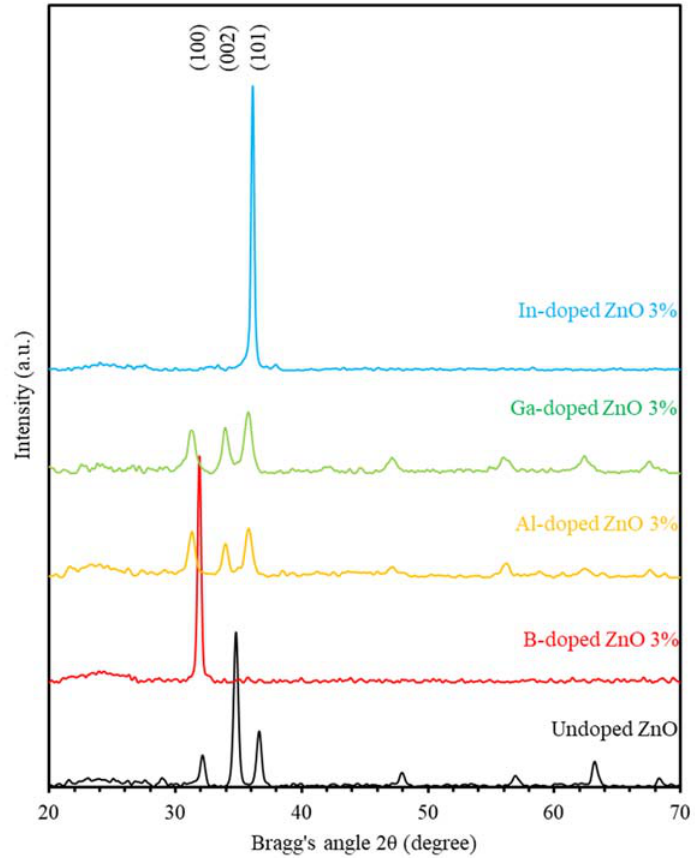
Figure4. TheX-raydi ff ractionpatternsofundopedZnOandgroupIIIelements(B,Al, Ga, andIn)-doped ZnO thin films at 3% doping Figure 4. The X ‐ ray diffraction patterns of undoped ZnO and group III elements (B, Al, Ga, and In) ‐ doped ZnO thin films at 3% doping concentration.